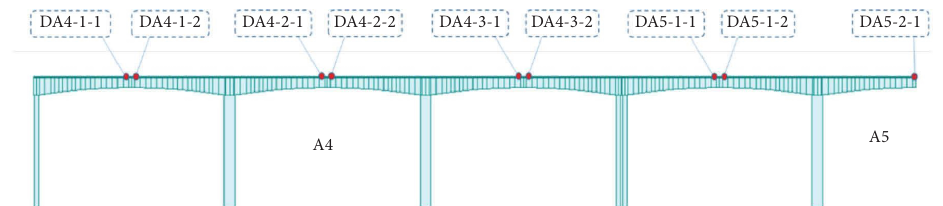
Figure 11: Deformation statistical point.